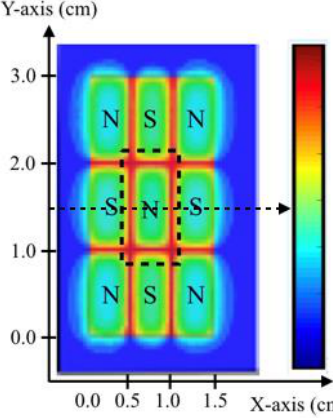
Figure 1. Configuration of rare earth permanent magnets which allows for a symmetric nonuniform field around the central magnet. A sketch of the array of the 9 magnets with an antiparallel N–S pole configuration is shown. The calculated magnetic force, ∆ χ B z ∂ B , component on the x- and y -planes ∂ z confirms the uniform magnitude of the force along all adjacent interfaces of the central magnet (red color). The dashed lines show the area of interest in our experiments.